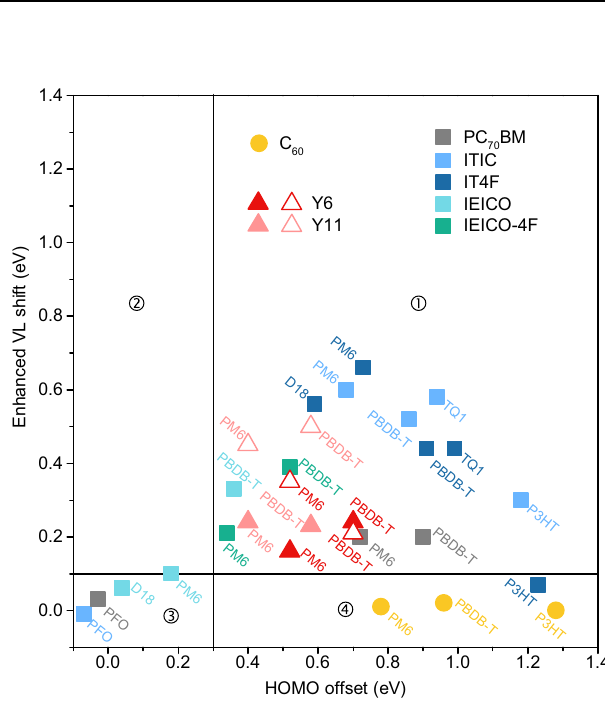
Fig. 5 Enhanced vacuum level (VL) shifts versus HOMO offsets measured from neat fi lms of the respective materials. Different bilayer fabrication methods are clari fi ed by the shapes of data points: squares for SC/SC, solid triangles for crosslinked-SC/SC, open triangles for SC/LS and circles for SC/evaporation, respectively. SC, LS, crosslinked-SC is for spin- coating, Langmuir-Schäfer, and spin-coating followed by crosslinking method, correspondingly.